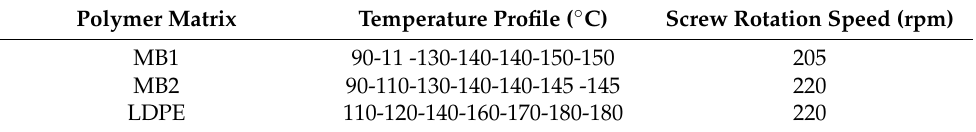
Table 1. Processing conditions in the twin screw extruder for the formulation of all the nanocomposites. Polymer